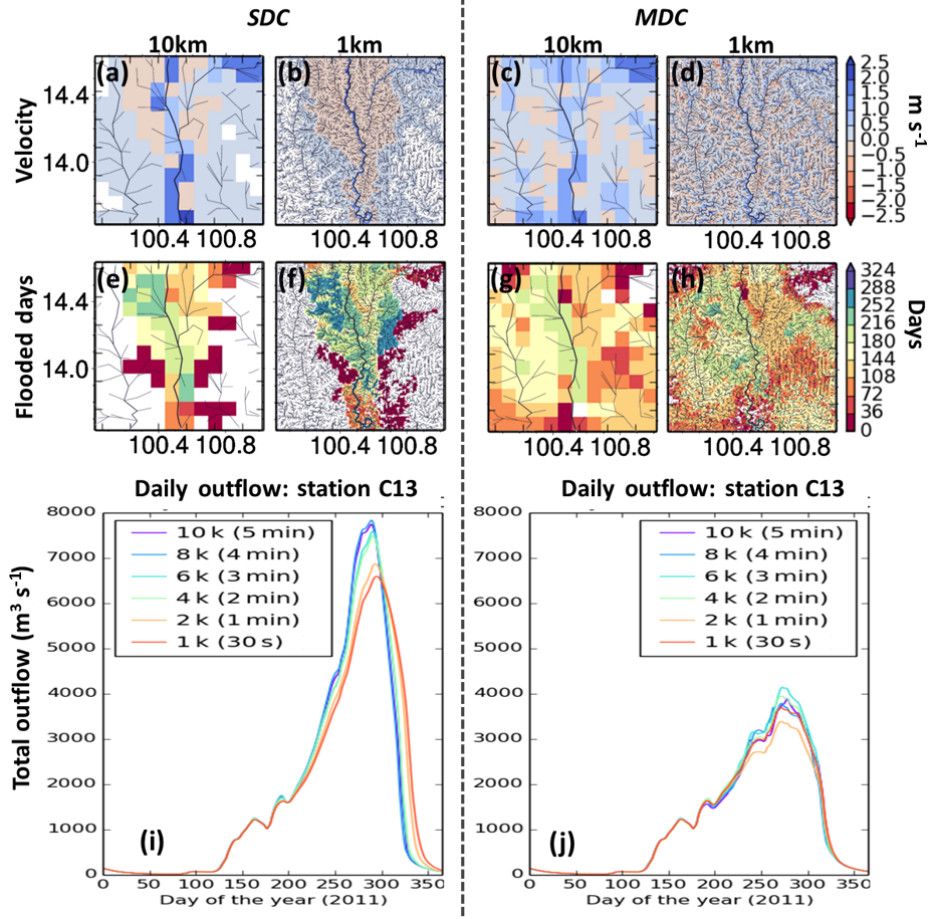
Figure 8. Impacts of spatial resolution and representation of MDC to (a–d) flow velocity, (e–h) number of days of flooding in a year, and (i–j) 2011 daily outflows (river + floodplain flows) at C13 Station. Panels (a–h) show simulation results at the lower part of the